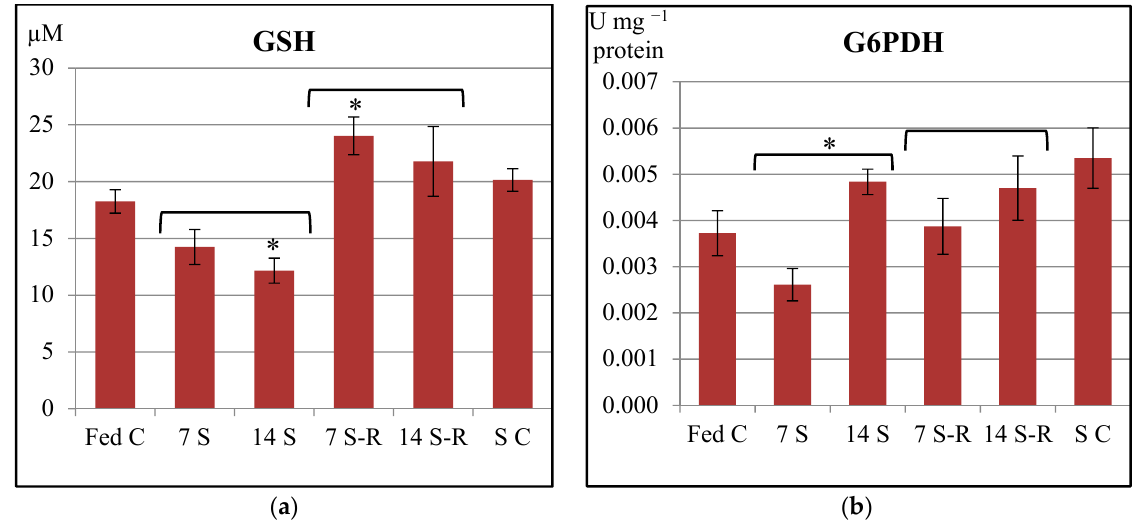
Figure 3. The level of other biomarkers involved in antioxidant defense mechanisms in the intestine of Acipenser stellatus juveniles subjected to different starvation/refeeding regimes. ( a ) The level of GSH; ( b ) glucose 6-phosphate dehydrogenase (G6PDH) specific activity. The data are illustrated as average value of the groups (n = 8) ± standard error of the mean (SEM). All data were statistically analyzed using one way—ANOVA. Statistical significance: * p < 0.05; the statistical significance of the changes is related to the fed control level and it is also presented between 7 S and 14 S groups and between 7 S-R and 14 S-R groups. Fed C—fed control group; 7 S—group starved for 7 days; 14 S—group starved for 14 days; 7 S-R—group starved for 7 days and refed 21 days; 14 S-R—group starved for 14 days and refed 21 days; S C—starved control.